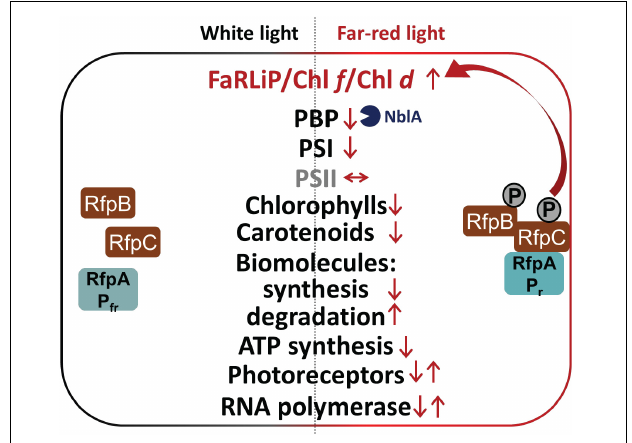
FIGURE 9 | Summary of changes in relative transcription levels for selected gene categories in C. fritschii 9212 cells in WL and FRL. Small upward arrows indicate that relative transcript levels are generally higher and downward arrows indicate lower relative transcript abundances. Paired upward and downward arrows indicate that specific genes in these categories show increases or decreases, respectively. Increased transcript levels for nblA in FRL probably lead to higher NblA protein levels, which further contributes to lowering of PBP levels in cells grown in FRL by enhancing degradation of PBPs in FRL (blue Pacman). The RfpABC regulators activate transcription of the genes in the FaRLiP cluster, including the genes encoding these three proteins, in FRL as shown indicated by the two arrows. Most other responses to FRL are independent of RfpABC regulation. In FRL C. fritschii 9212 WT cells have transcriptional responses to reduce their overall rates of photosynthesis and growth, anabolism, and energy production, while enhancing the degradation of lipids and fatty acids and proteins to produce energy, reducing power and precursor